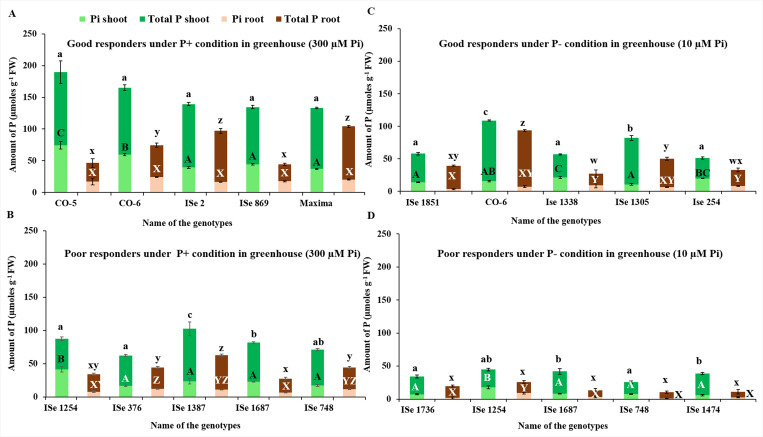
Inorganic (green) and total P assay (brown) for each of the five high performers and low performers of foxtail millet genotypes under P- (10 μM Pi) and P+ (300 μM Pi) conditions in greenhouse conditions.A, high performers under P+; B, low performers under P+; C, high performers under P-; D, low performers under P-. The letters over the bars indicate statistically significant differences if the letters are different as p<0.05. The vertical lines indicate error bars.